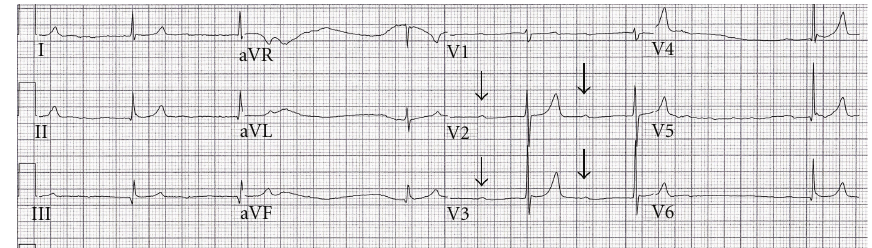
Figure 1: Initial ECG demonstrating tall, symmetric T waves, and prolonged PR intervals (P waves marked with arrows).